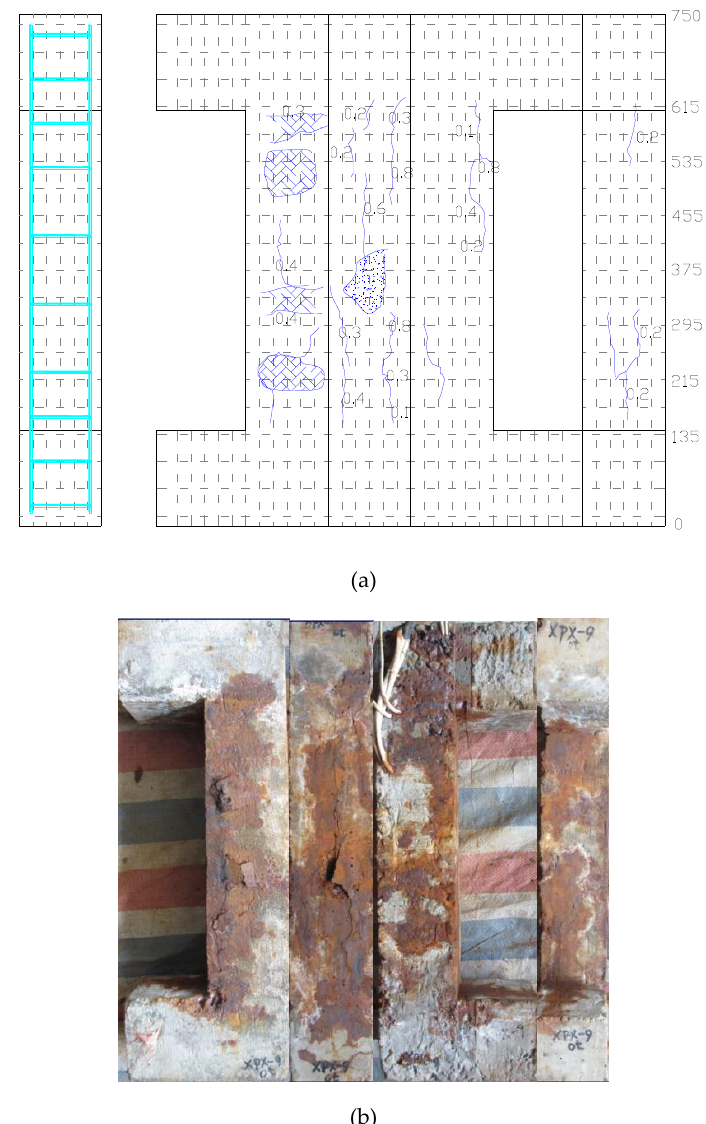
Figure 7. Corrosion-induced crack patterns: ( a ) cracking maps of corroded reinforced concrete (RC) column; ( b ) distribution of cracks and leakage of rust from reinforcement corrosion on the surfaces of the RC column specimens. Unit: mm.